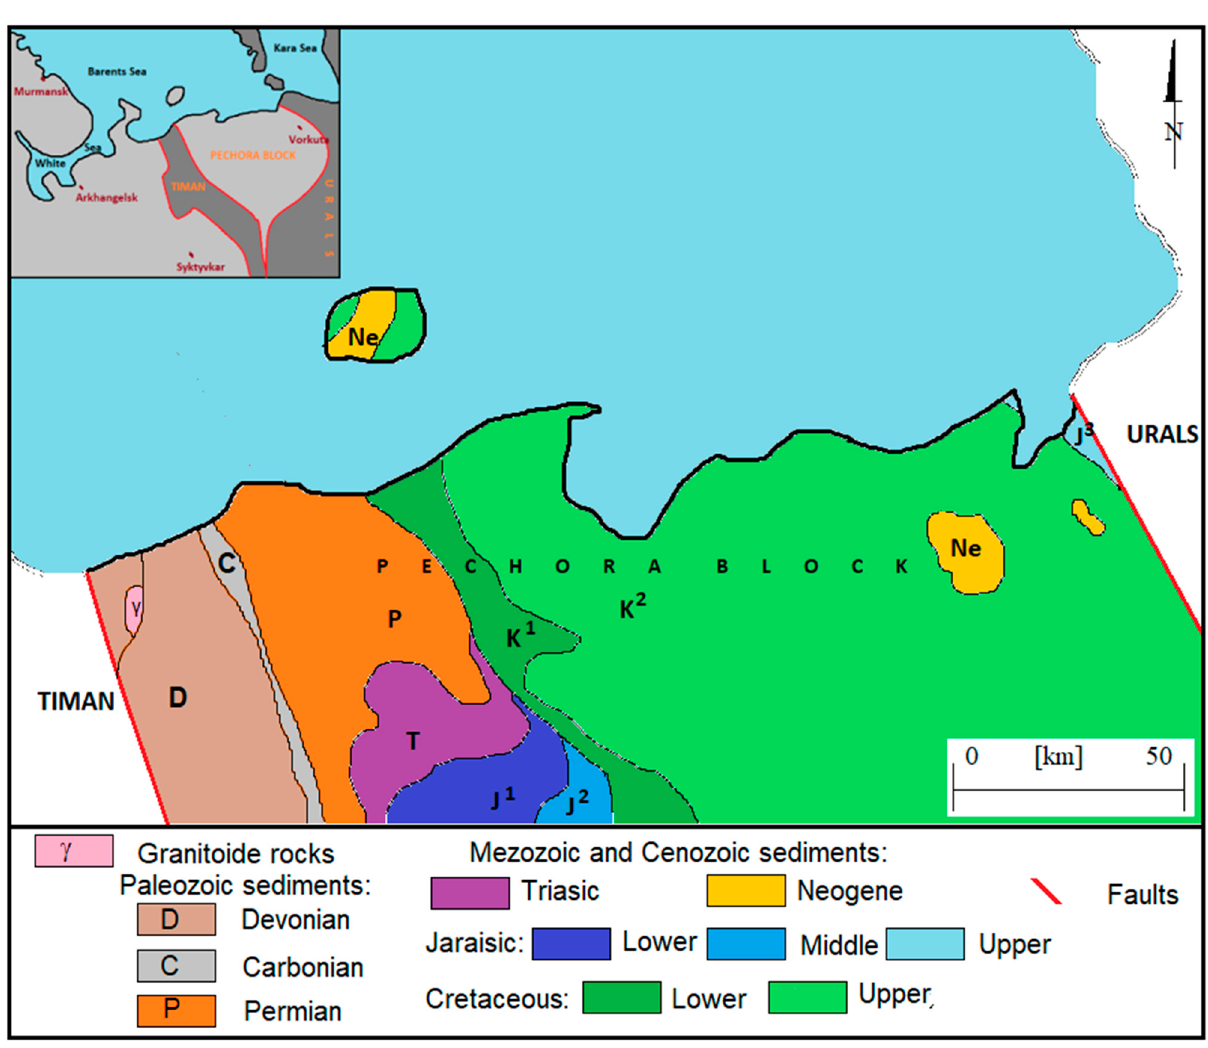
Figure 1. Situated sketch of the Pechora geology (after Andreichev, Andreicheva, Antonovskaya, Danilov, Kuznietsov, Parmuzin, Pavlindis, Prischepa [5–7,16–19,22], simplified by authors).